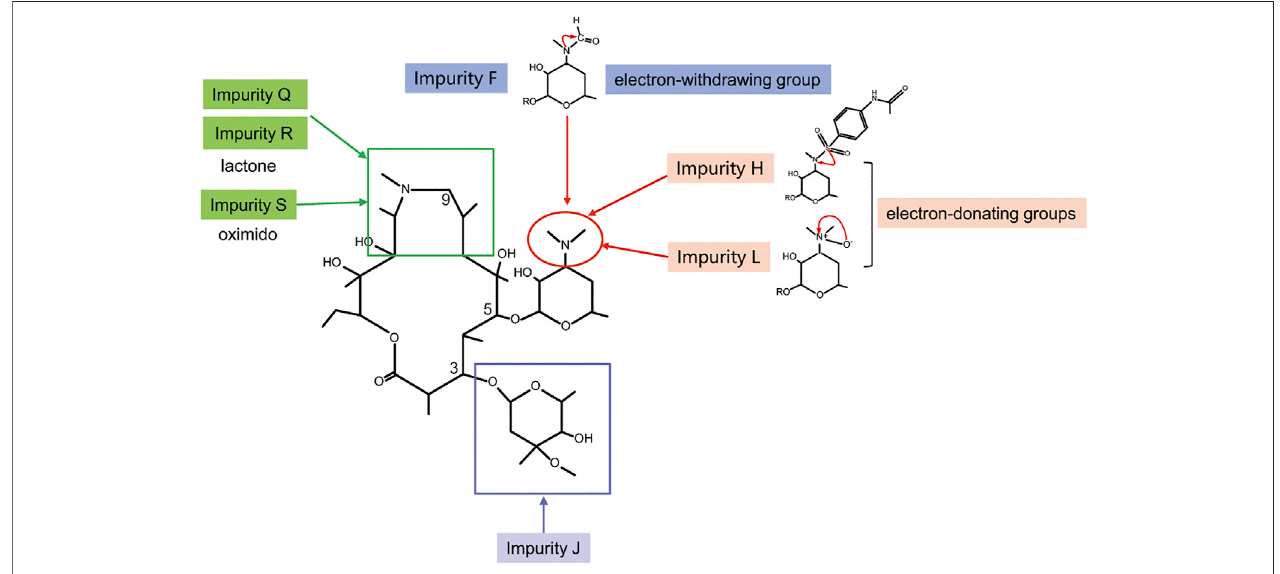
FIGURE 7 | Structure – hepatotoxicity relationship of azithromycin